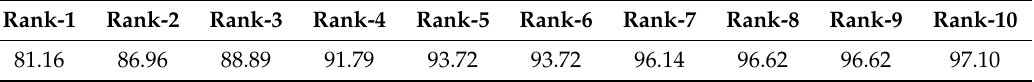
Table 4. Rank scores from 1 to 10 considering multiple samples per identity and different floors.